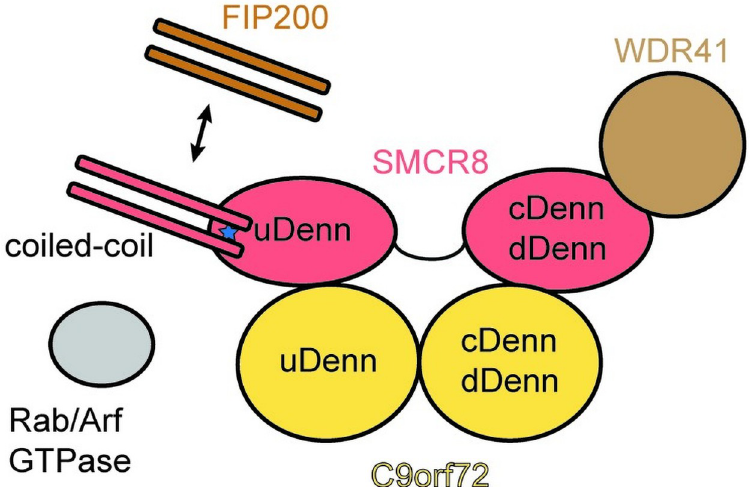
Fig 6. Schematic of C9orf72-SMCR8 complex with the position of the interaction proteins in cells. Potential active site residue is situated behind the coiled coil and is indicated in blue. cDenn, central Denn; dDenn, downstream Denn; Denn, differently expressed in normal and neoplastic cells; uDenn, upstream